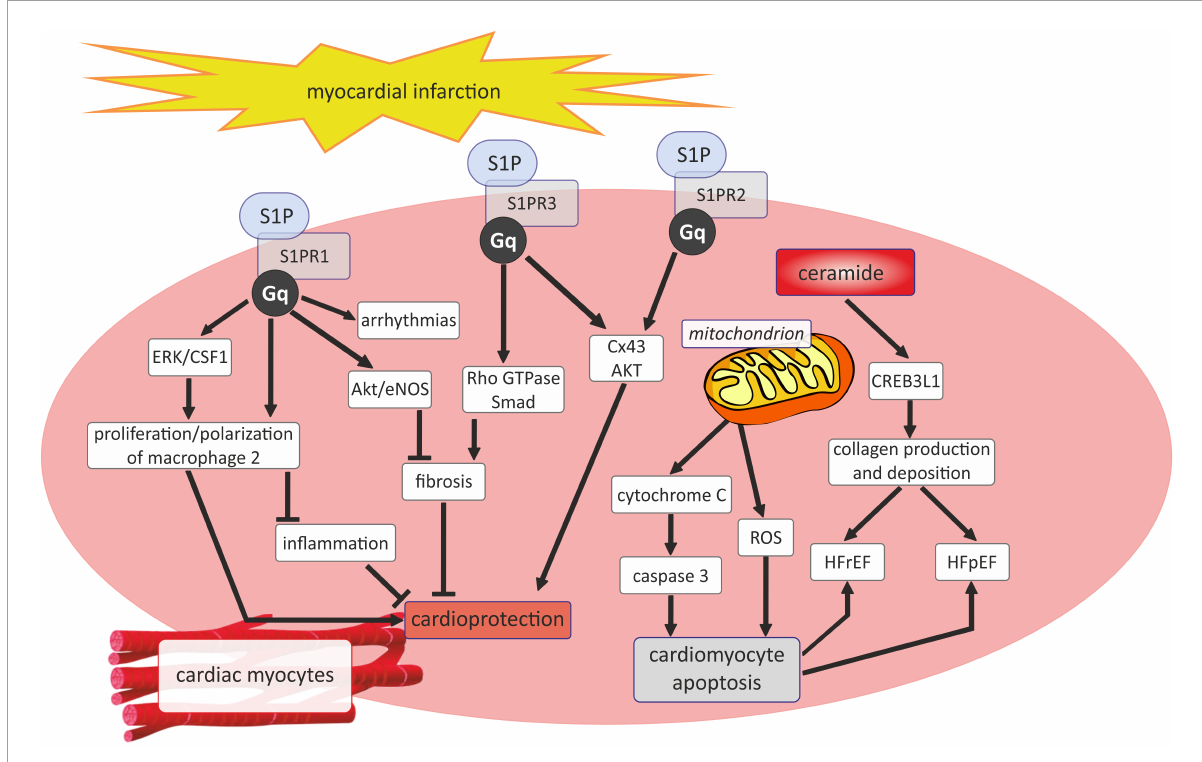
FIGURE4 Sphingosine 1-phosphate and ceramide signaling in myocardial infarction. AKT, serine/threonine protein kinase B; CREB3L1, cyclic adenosine monophosphate responsive element binding protein 3 like 1; CSF1, colony stimulating factor 1; Cx43, connexin43; ERK, extracellular signal-regulated kinases; G q , G q protein alpha subunit; HFpEF, heart failure with preserved ejection fraction; HFrEF, heart failure or heart failure with reduced ejection fraction; Rho GTPase, family small GTPase; ROS, reactive oxygen species; SMAD -suppressor of mothers against decapentaplegic; S1P, sphingosine-1-phosphate; S1PR1, sphingosine-1-phosphate receptor 1; S1PR2, sphingosine-1-phosphate receptor 2; S1PR3, sphingosine-1-phosphate receptor